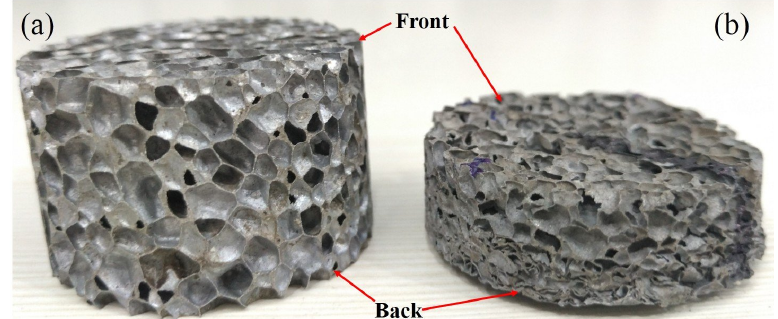
Figure 2. Aluminum foam samples ( a ) before and ( b ) after shock exposure.